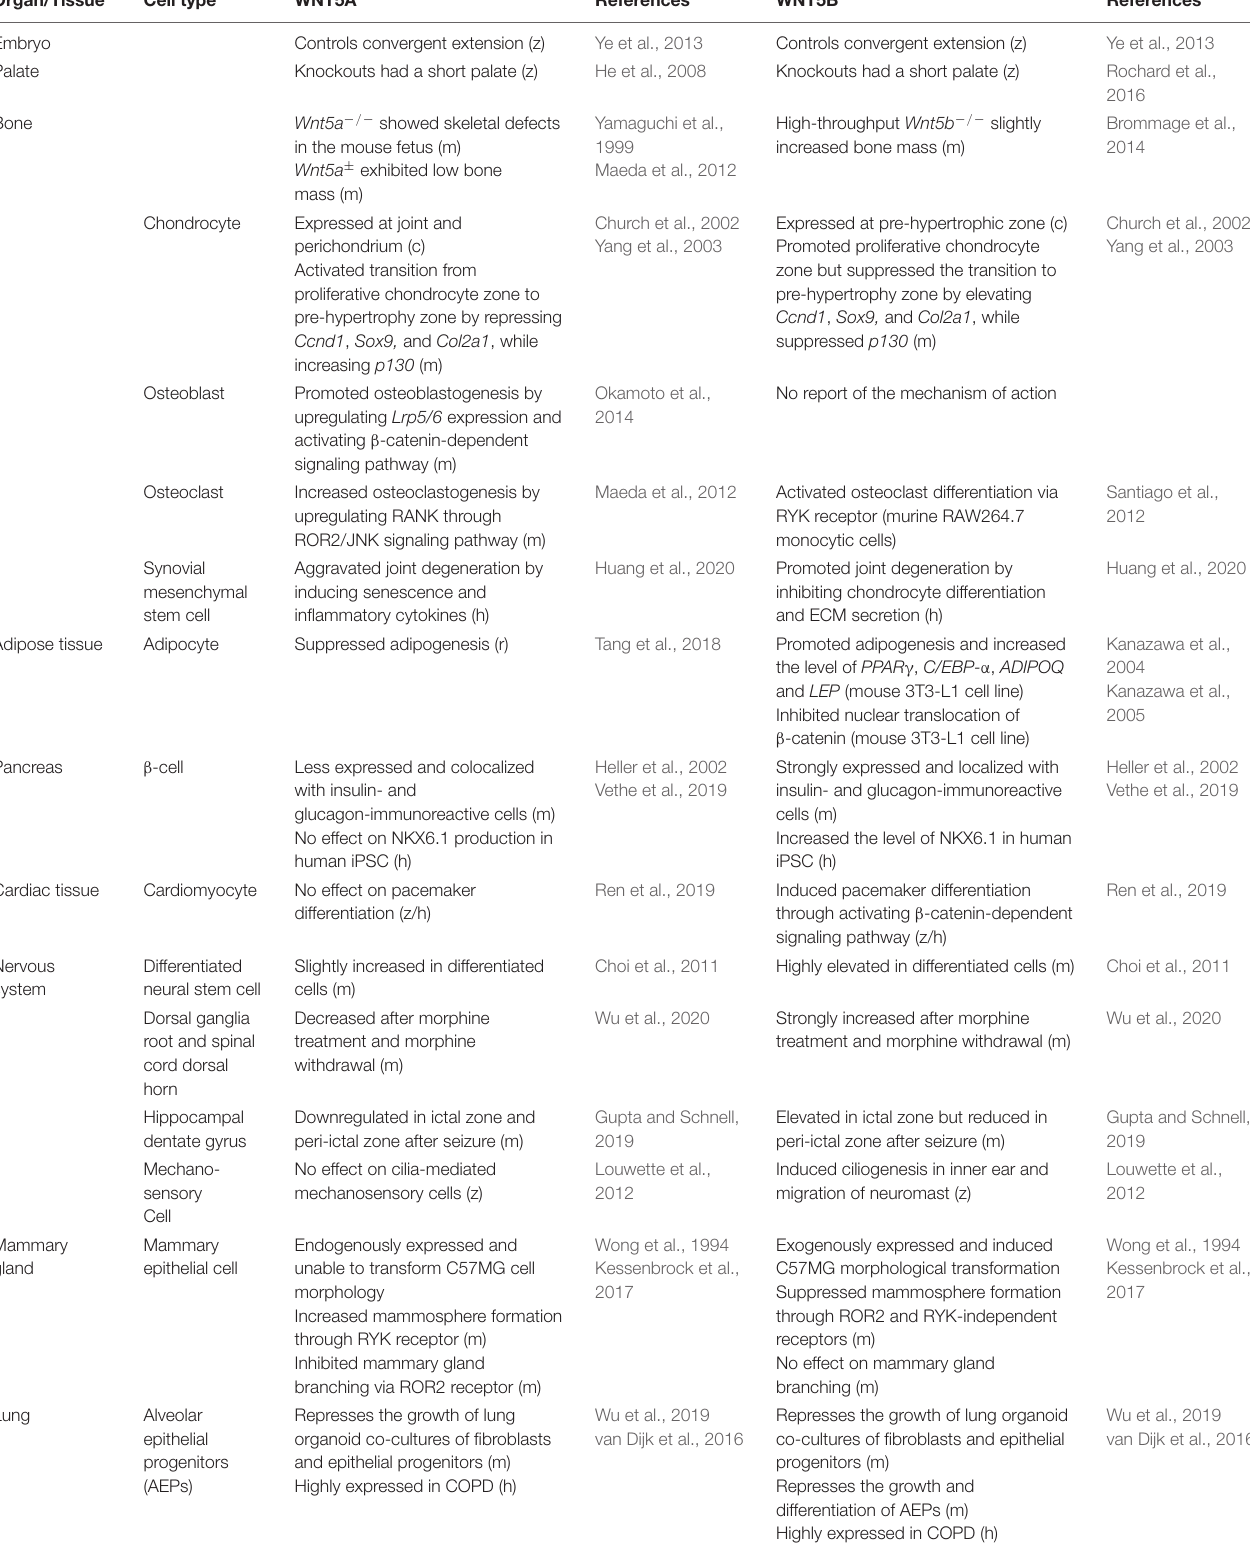
TABLE 1 | Distinct effects of WNT5A and